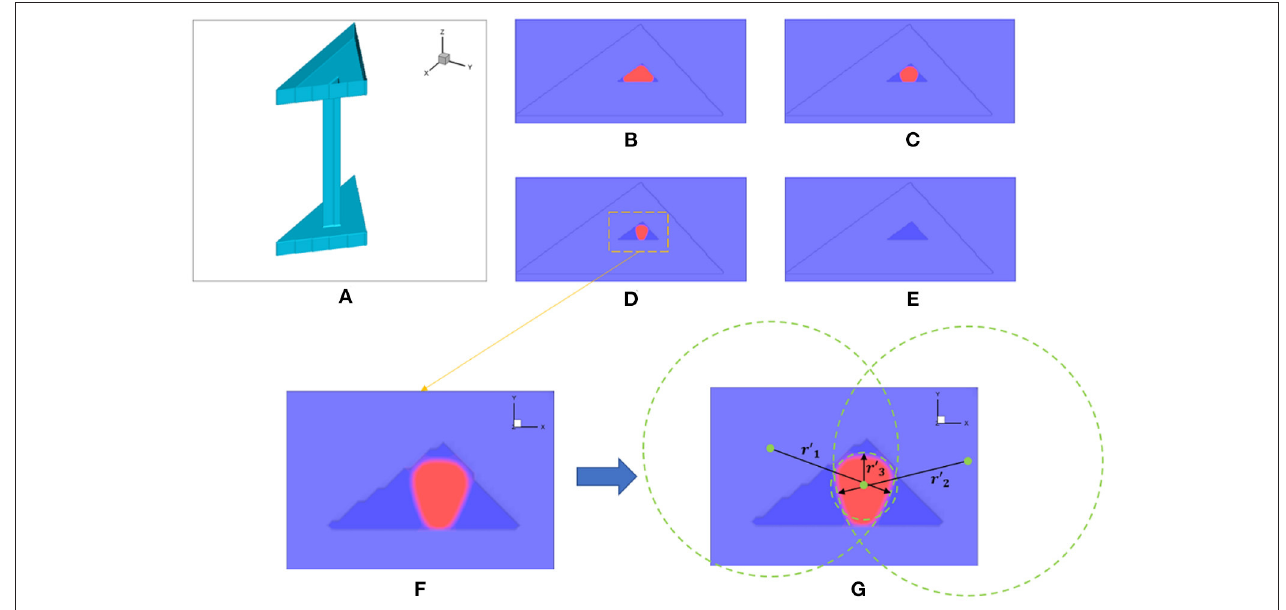
FIGURE 5 | (A) PTP configuration with G = 0.040 defined for assessing the snap-off event in pore-throat. Evolution of cross section of a pore-throat with G = 0.040 from LB simulation during snap-off event: (B) beginning of imbibition, (C) moving the interface toward the center, (D) before snap-off, (E) and after snap-off. (F) Higher resolution of pore-throat cross section before snap-off. (G) Cross-sectional approach in evaluation of capillary pressure based on the radius of curvature of three corners.